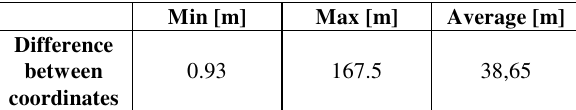
Table 4. Results of the difference between image coordinates measured by the U-blox 8T and the camera positions estimated by the software Agisoft